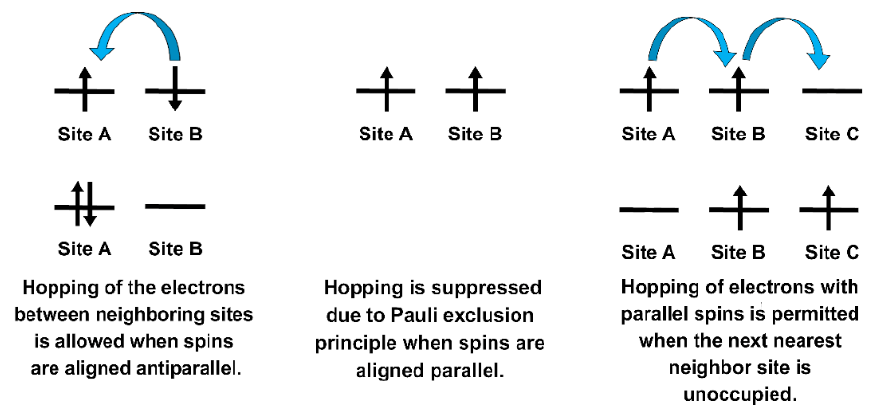
Figure 4. Simple sketch of the direct exchange mechanism between antiparallel ( left ) and parallel spins ( right ).